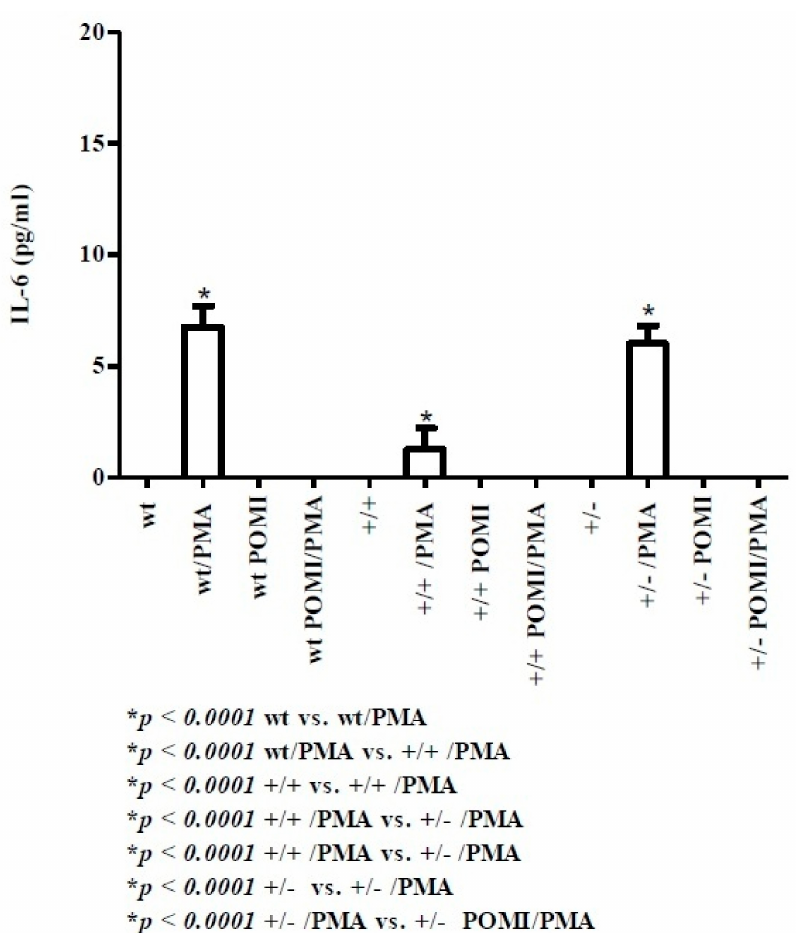
Figure 6. Levels of IL-6 in splenic supernatants from cell cultures of mice at day 30. For methods, abbreviations, and statistical analysis, see Figures 1 and